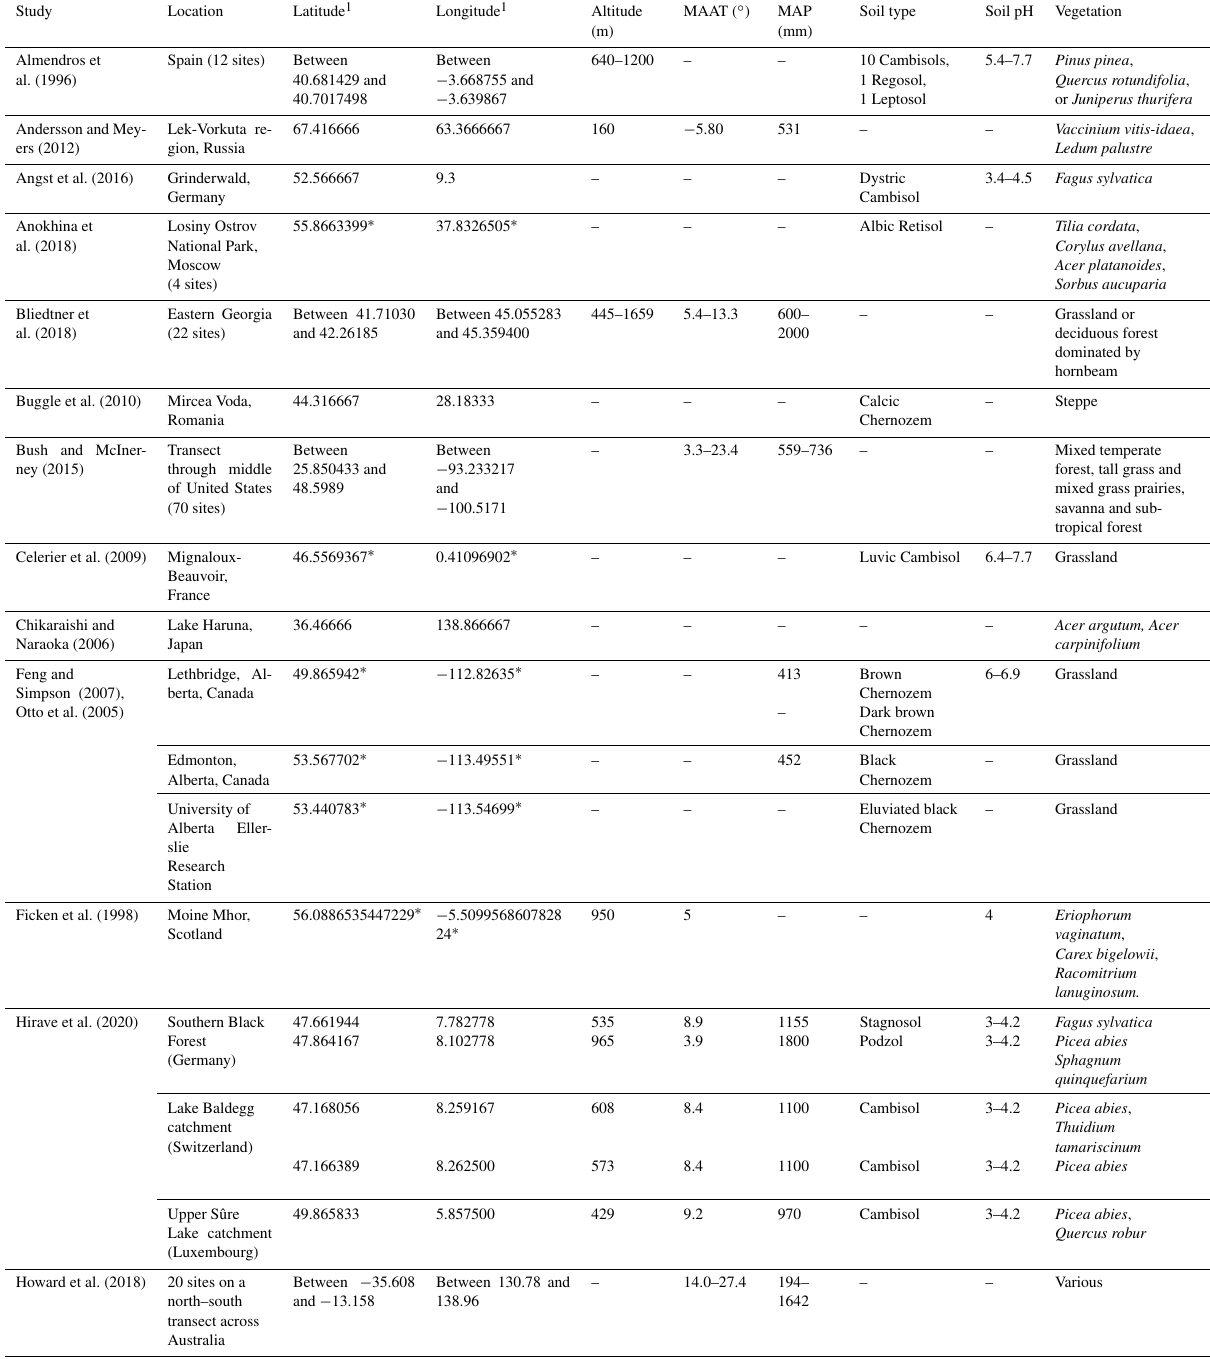
Table 2. Site characteristics for open plant–soil